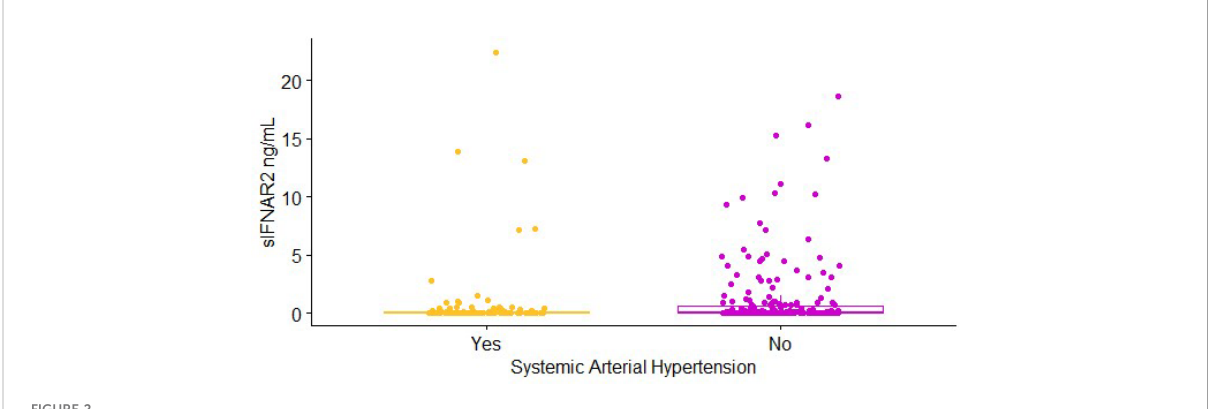
FIGURE 2 Soluble IFNAR2 (sIFNAR2) plasma levels of severe COVID-19 patients (n = 347) divided according to the comorbidity systemic arterial hypertension (SAH) (Yes: n = 121, yellow dots; No: n = 226, purple dots). sIFNAR2 level was evaluated by ELISA. Statistical comparison was performed using Mann-Whitney U Test, p <